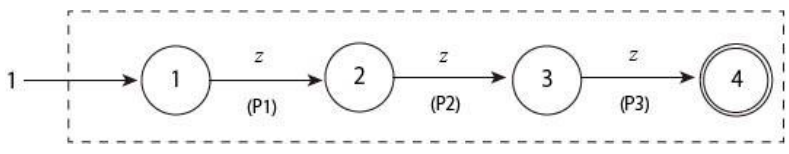
Figure 3. Phase structure for the software debugging process in Model A